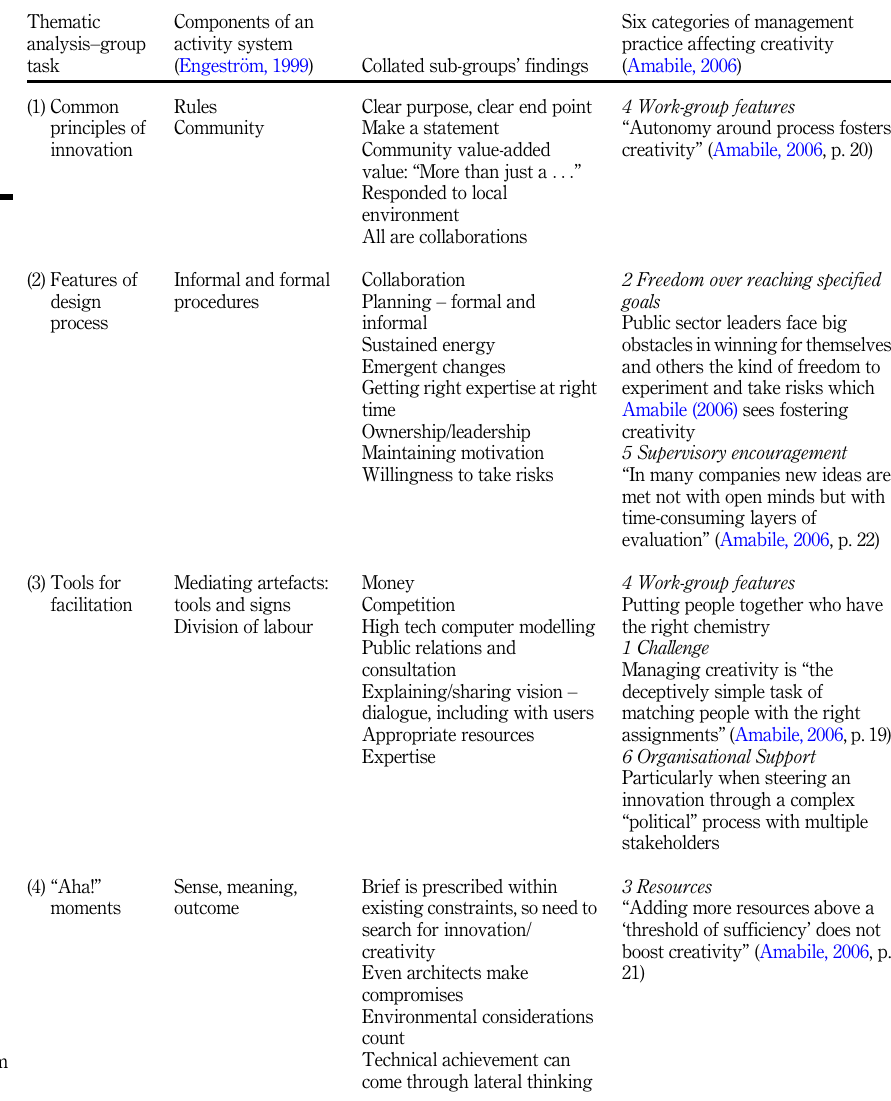
Table 1. Chart of findings from one